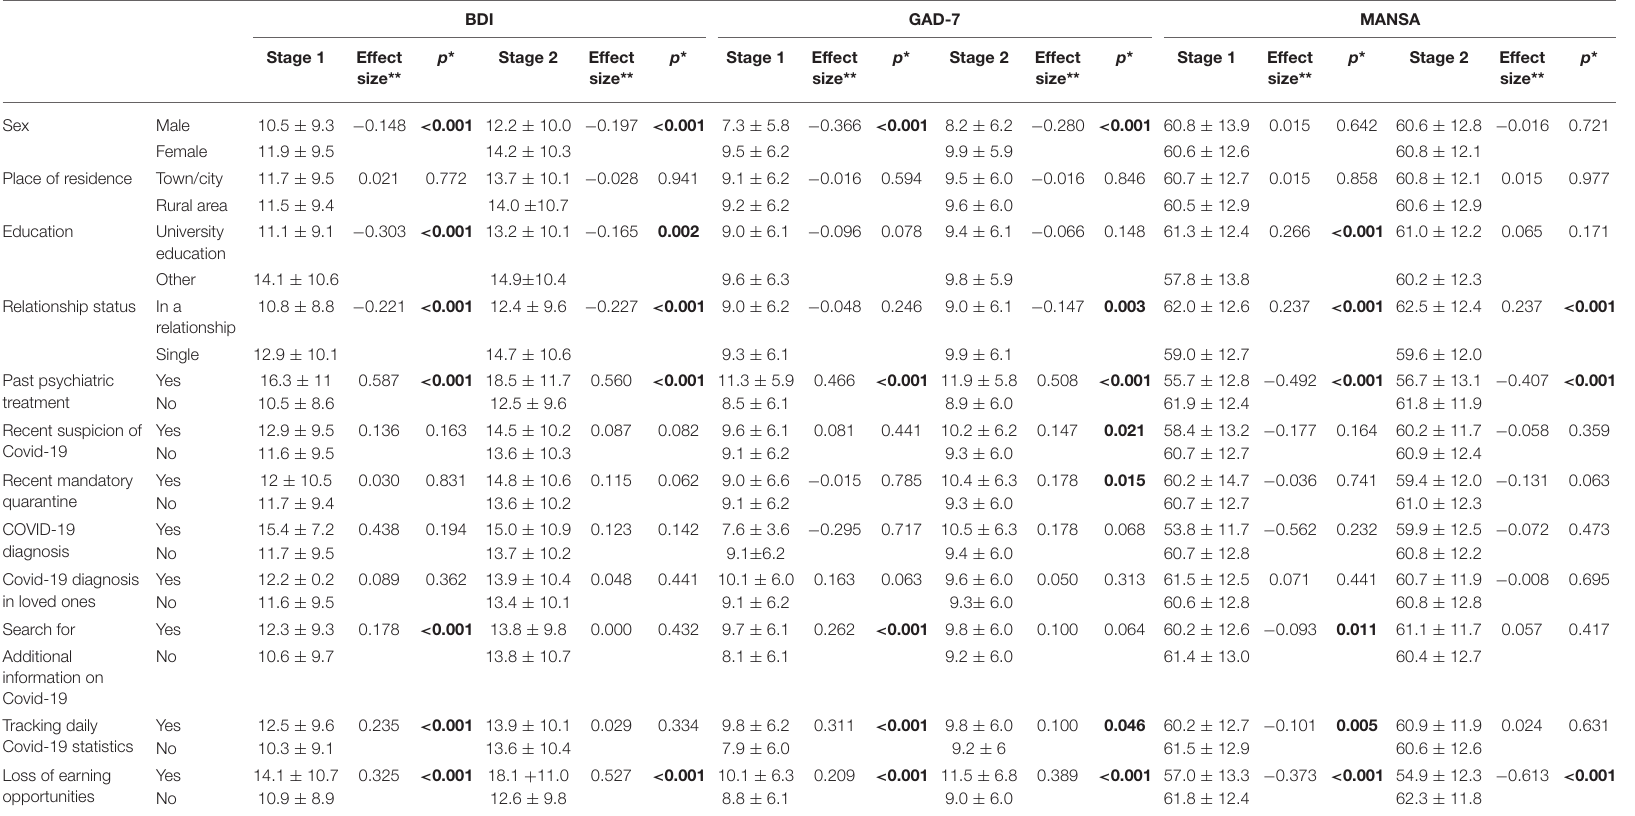
TABLE 5 | Influence of sociodemographic, medical, and psychiatric history variables on individual scale scores in both stages of the study.